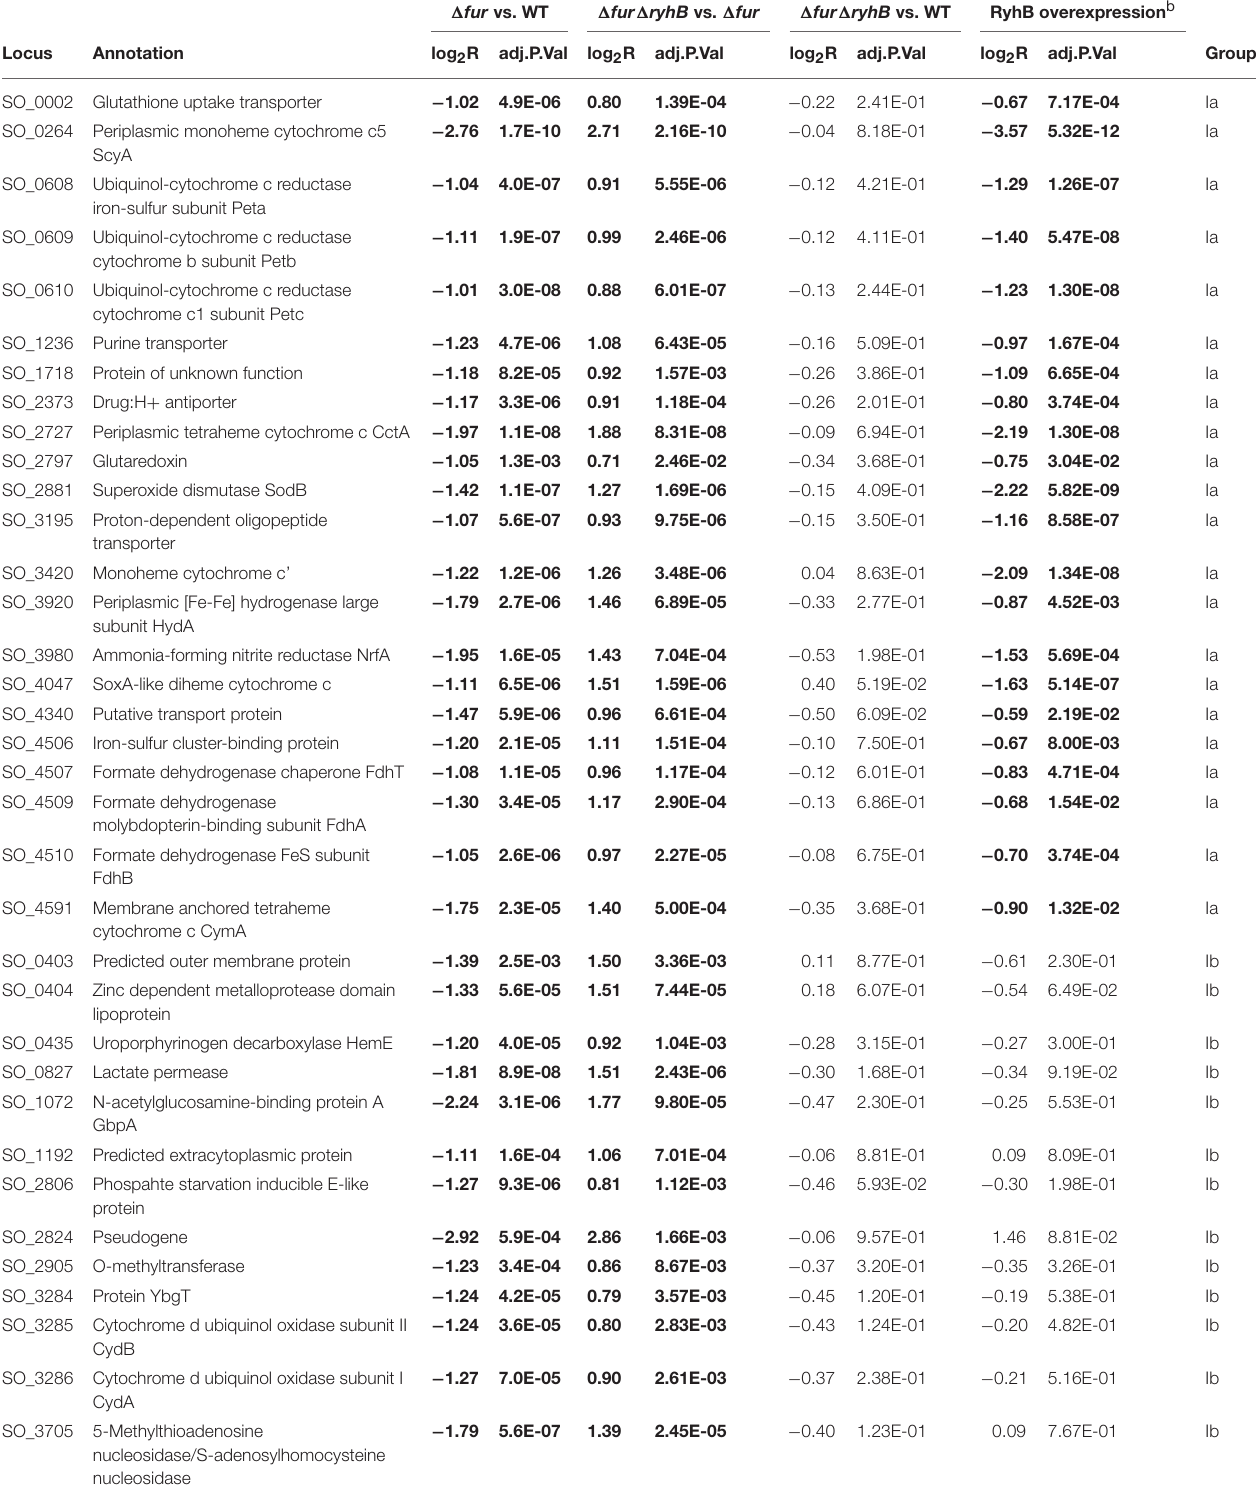
TABLE 1 | RNAseq data of genes expressed at lower level in 1 fur mutant relative to wild-type S. oneidensis MR-1 a . 1 fur vs.